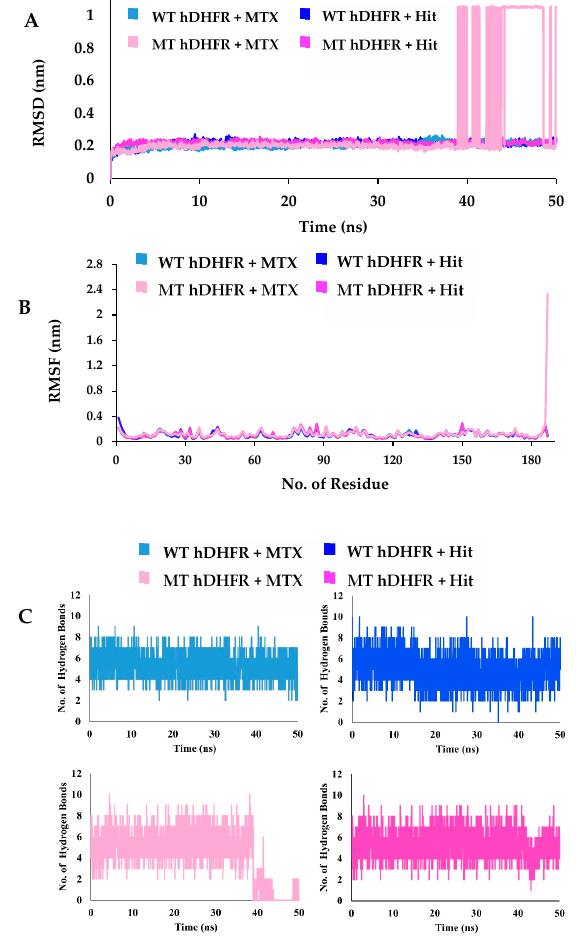
Figure 4. RMSD analysis of the reference (MTX) and hit compound (MTX-analog). ( A ) RMSD of the protein-ligand complex of wild type and mutant hDHFR revealed their stability throughout the simulation, with no abnormal behavior in all systems except for MTX in complex with MT hDHFR. ( B ) RMSF per residue plot for all the systems portrayed their residues RMSD is stable except for MT hDHFR ligand (MTX) which showed a high fluctuation level. ( C ) The number of intermolecular hydrogen bonds between protein and ligand during 50 ns MD simulations. Light blue and pink colors represent MTX in wild type and mutant hDHFR, respectively, while dark blue and magenta represent the Hit compound in wild type and mutant hDHFR, respectively.